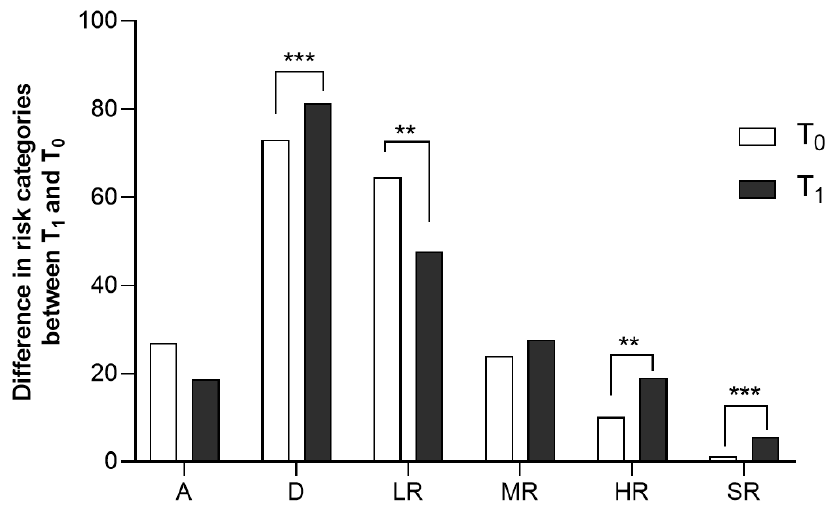
Figure 2. Differences in risk percentages over the time interval considered in our study, T 1 vs. T 0 . A = Abstainers; D = Drinkers; LR = Low Risk; MR = Moderate Risk; HR = High Risk; SR = Severe Risk. ** p < 0.01; *** p < 0.001 vs. T 0 .